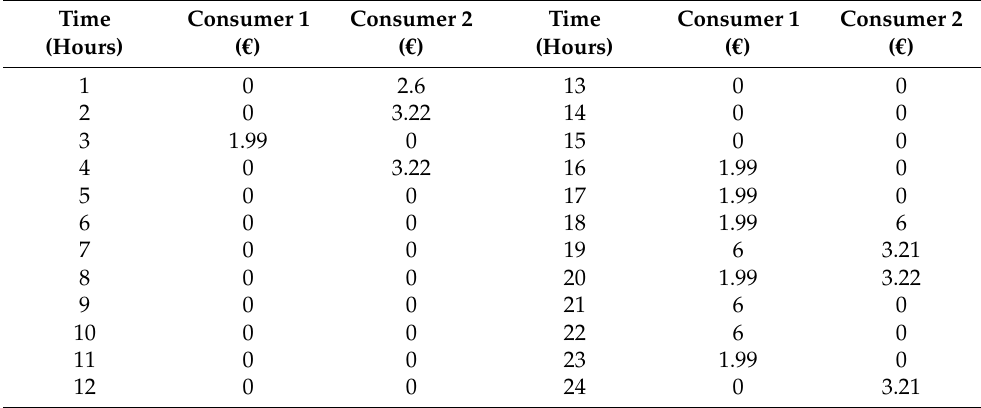
Table 10. Hourly inventive payment per